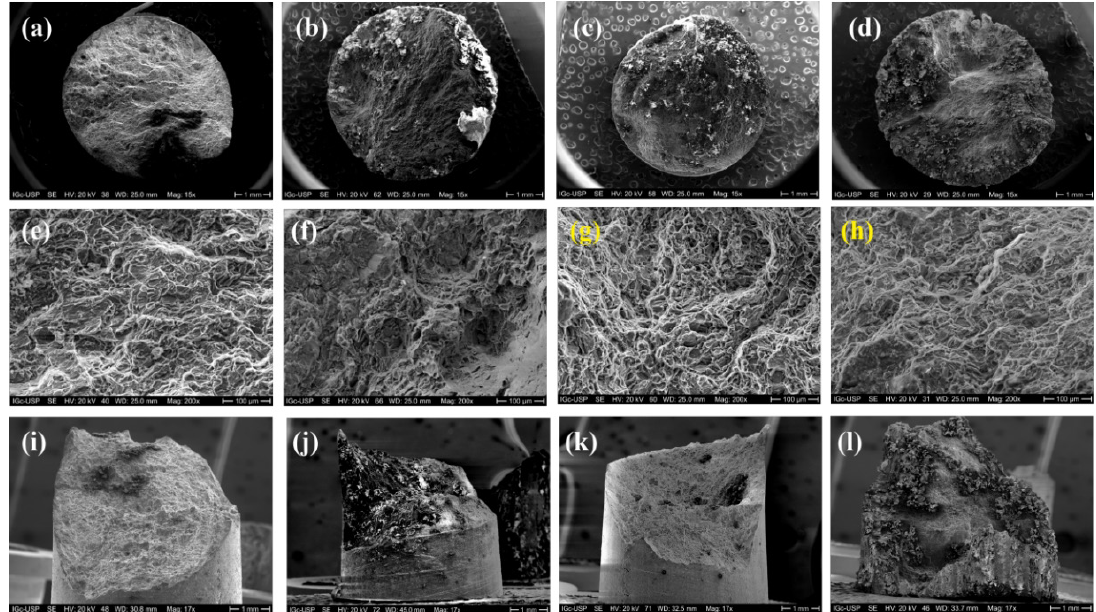
Figure 15. SE-SEM micrographs of the fracture surfaces of the BO-20 and BO-30 samples: a) BO-20 cross-section; specimen tested in air; b) BO-20 cross section; specimen tested in 0.1 M NaCl solution; c) BO-30 cross-section; specimen tested in air; d) BO-30 cross section; specimen tested in 0.1 M NaCl solution; e) high magnification view of (a); f) high magnification view of (b); g) high magnification view of (c); h) high magnification view of (d); i) BO-20 side view; specimen tested in air; j) BO-20 side view; specimen tested in 0.1 M NaCl; k) BO-30 side view; specimen tested in air; j) BO-30 side view; specimen tested in 0.1 M